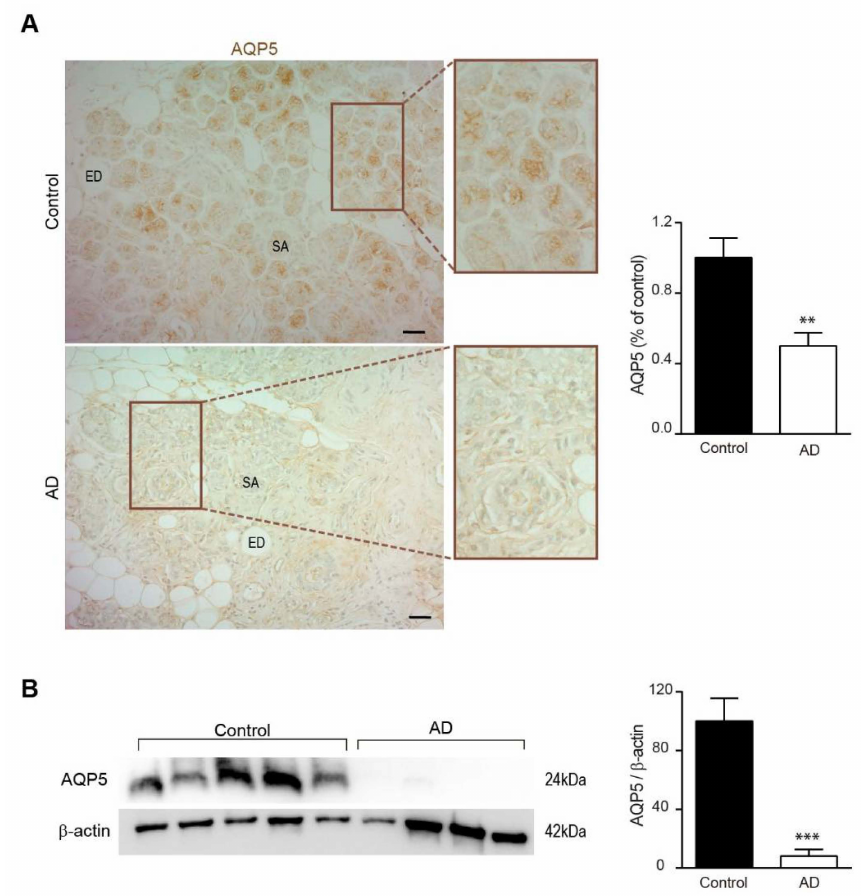
Figure 2. Expression of AQP5 in human submandibular gland. Localization of AQP5 in sub- mandibular gland from AD and control post-mortem samples was detected by immunostaining and western blot. ( A ) Representative AQP5 stained sections of submandibular glands from AD and control post-mortem samples. All sections were counterstained with hematoxylin. In the right his- togram, quantification of the AQP5 signal (Table 1) is shown. Scale bar = 20 µ m. Inserts show higher magnification views. ( B ) Western blot analysis showing AQP5 levels in submandibular glands from AD and control post-mortem samples ( n = 8, per group). Representative western blot and histogram with their densitometric analysis (right panel) are shown. Data are represented as mean ± SEM. Differences between groups were assessed using the Mann–Whitney test. ** p < 0.01; *** p < 0.001. SA: serous acini; ED: excretory